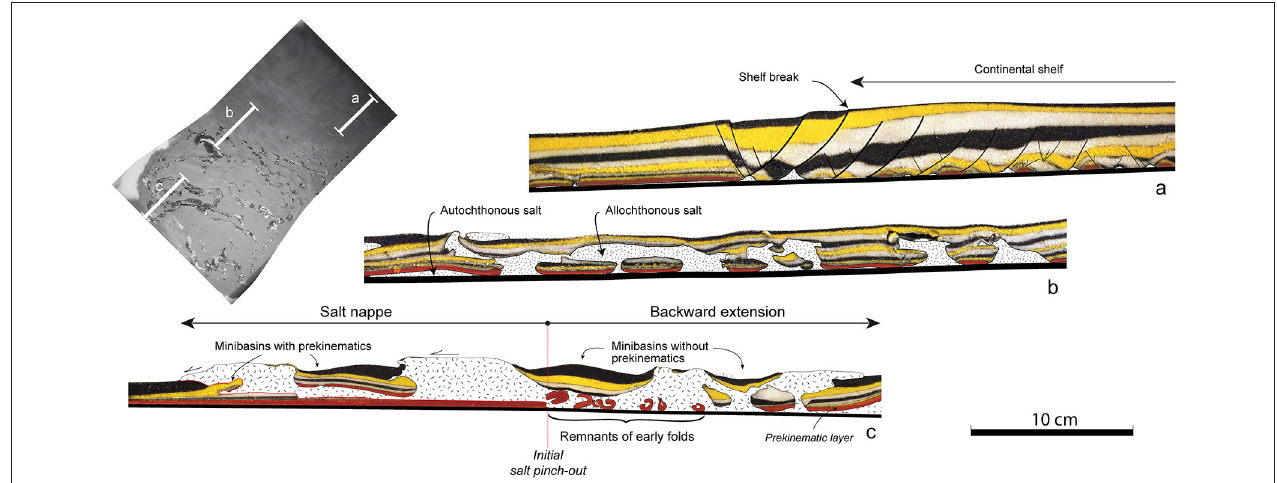
FIGURE 7 | Cross-sections showing the structures that characterize the main deformation domains in the model (See location in the insert: 215h top view in Figure 5 ). (a) Growth structure of the continental shelf. SB1 to SB4 correspond to successive shelf break locations. (b) Rafts and salt diapirs in the updip extensional domain. (c) Frontal salt nappe and neighboring backward extensional domain. Red: prekinematic sand layer. White: Silicone putty (salt). Yellow, black, and white: synkinematic sand